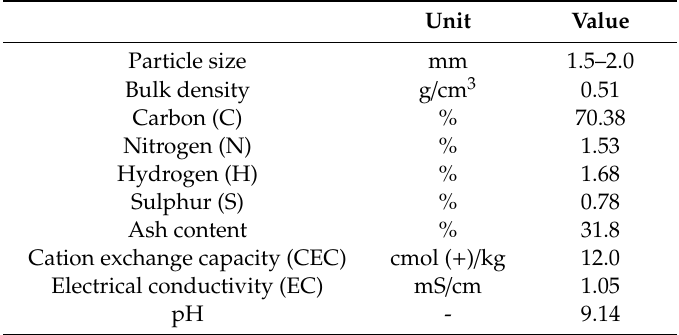
Table 1. Chemical characteristics of pure biochar applied in the